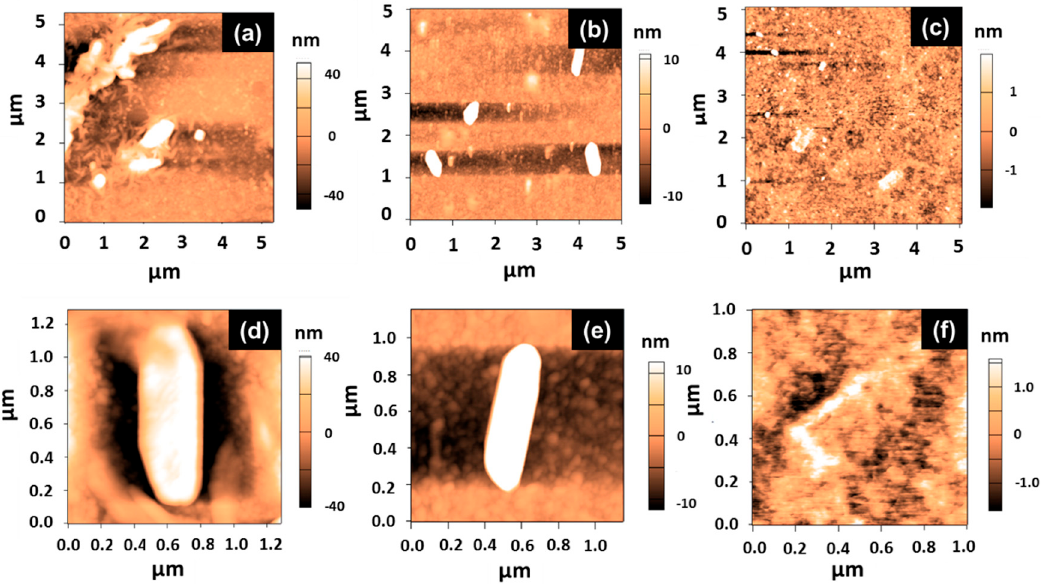
Figure 9. Atomic force microscopy (AFM) images of E. coli MG1655. ( a – c ) Height images at large scan and ( d – f ) height images at small scan ( a , d ) before, ( b , e ) after 1.5 h, and ( c , f ) after 3 h of photocatalysis.